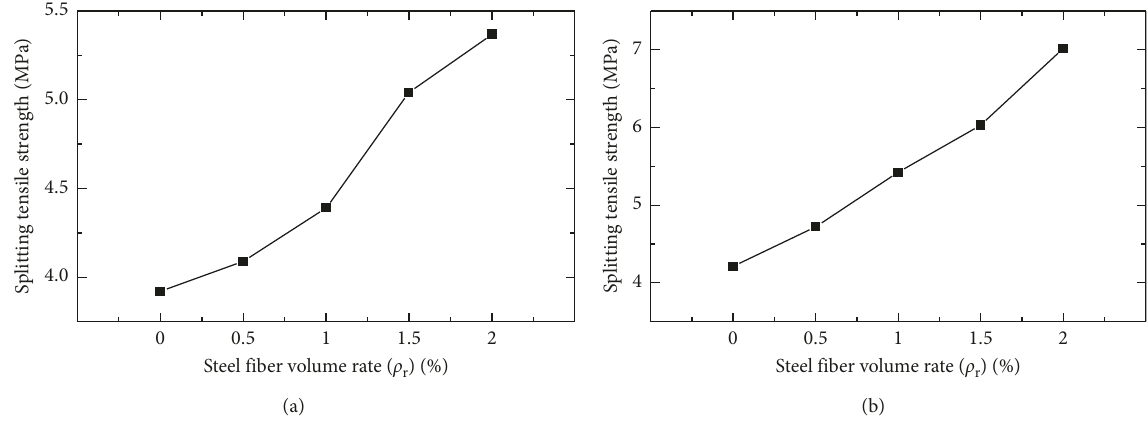
Figure 12: Relationship between splitting tensile strength and steel fiber content. (a) CF50; (b) CF60.